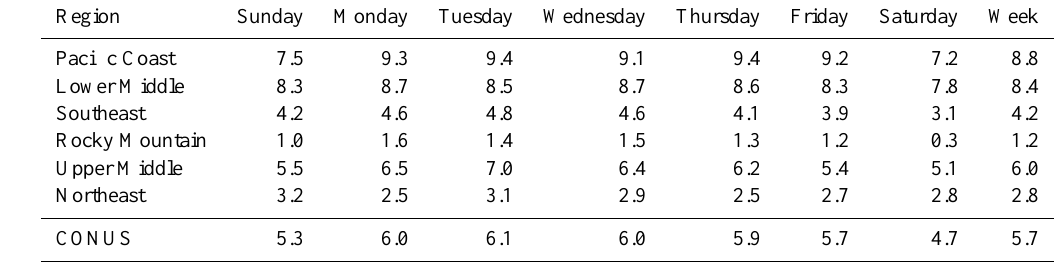
Table 8. NO 2 biases for the different days of the week in the six predefined regions and CONUS. June–September 2010. Unit: ppbv. Region